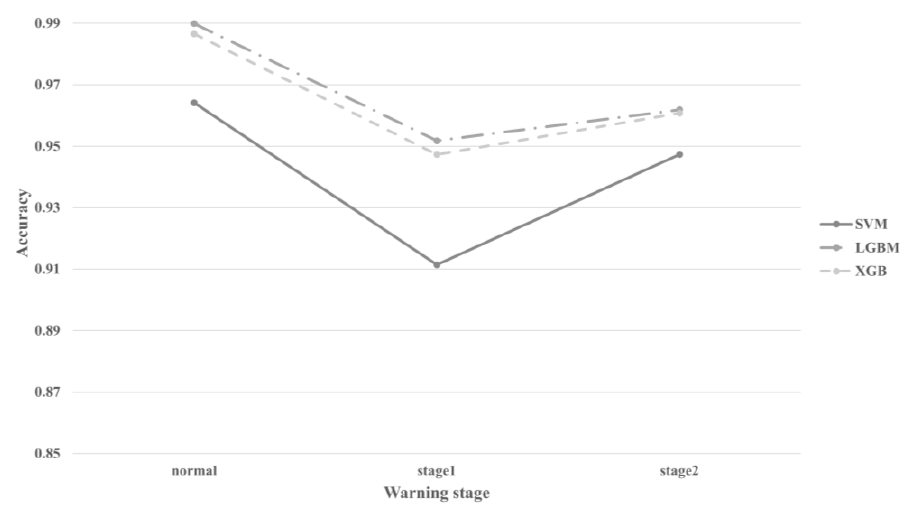
Figure 5. Accuracy at each stage of the FCW model based on three different algorithms.